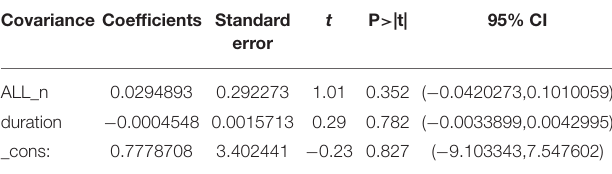
hand (20 Hz, with pulse rate of 300 µ s), but the MG intensity TABLE 4 | Results of meta-analysis regression.